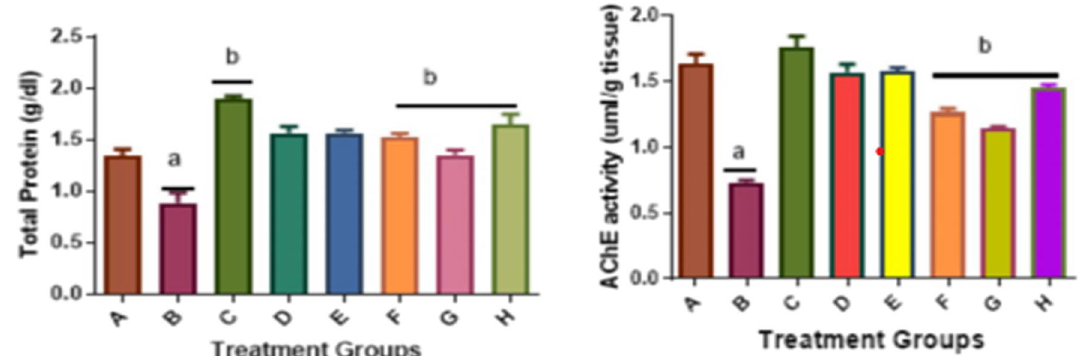
Fig. 4 Levels of total protein and acetylcholinesterase activity in the brain of male Wistar rats of different experimental groups. Values are mean SD (n 5), a significantly different compared with the negative control group A (p < 0.050). b ± = = positive control group B treated with KBrO3 only (p < 0.05). Group A received distilled water, B: 30 mg/kg KBrO3, C: 50 mg/kg Quercetin, D: 300 mg/